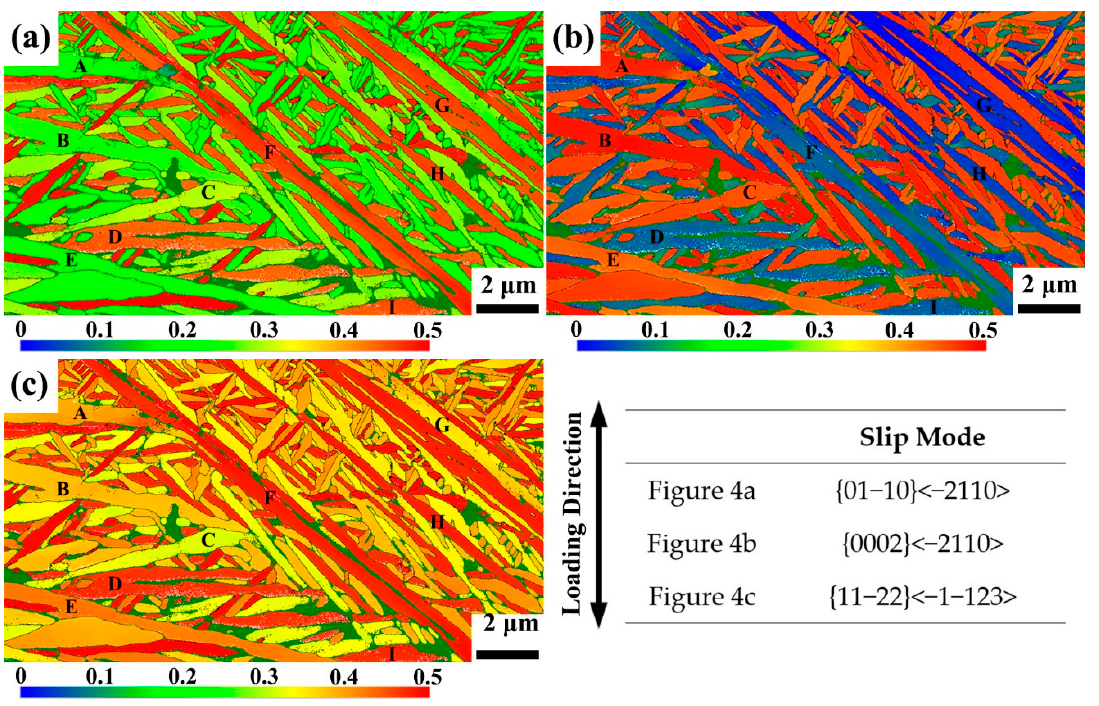
Figure 4. Schmid factor distribution of possible slip systems in the same area as in Figure